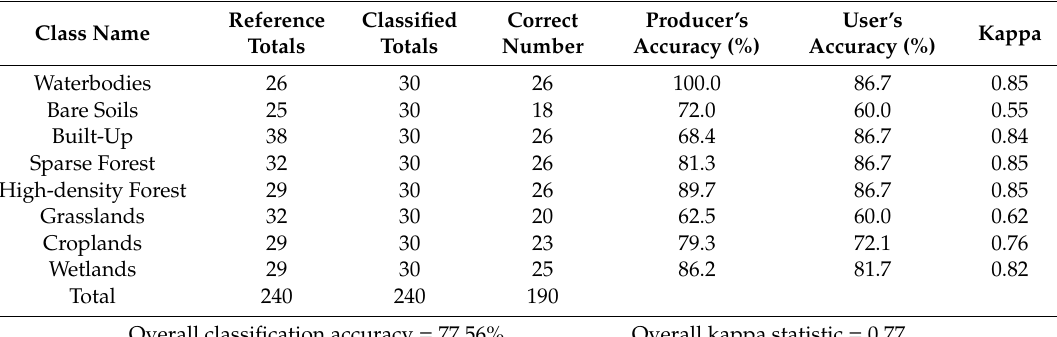
Table 4. Accuracy assessment for the study